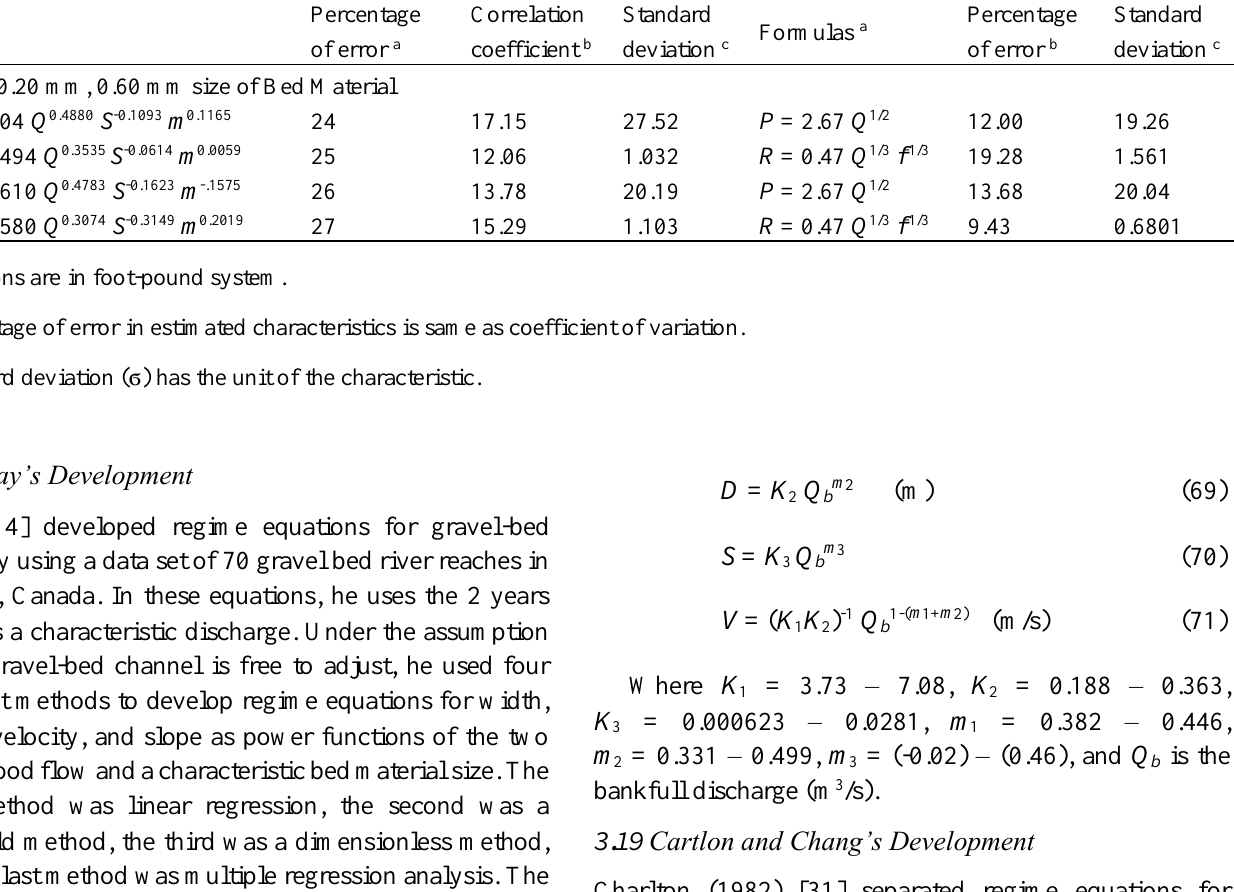
Comparison of Derived and Lacey Formulas Statistical